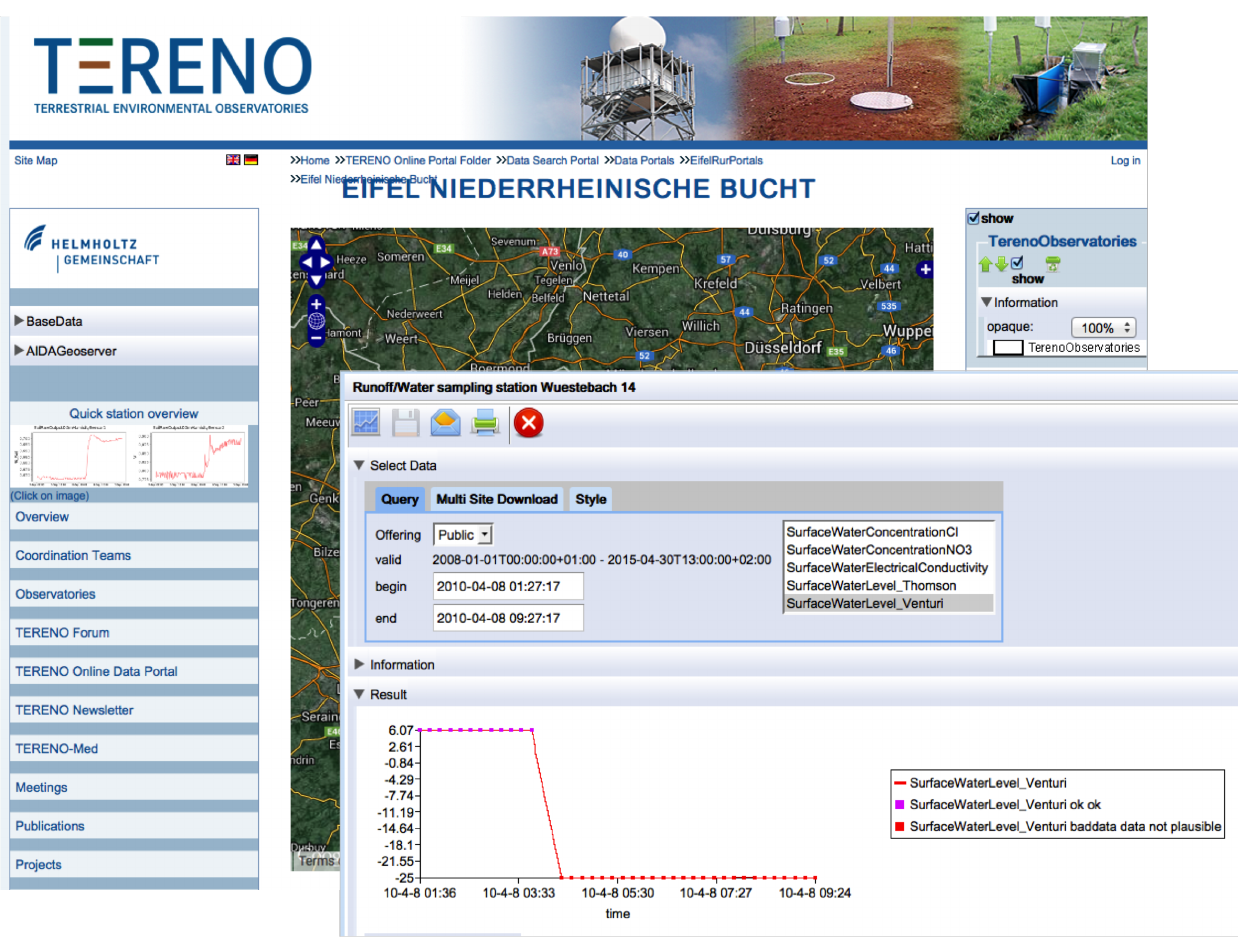
Figure 8. Search and discover observation data with TEODOOR web portal. Red data points indicate bad data, whereas magenta data points indicate good